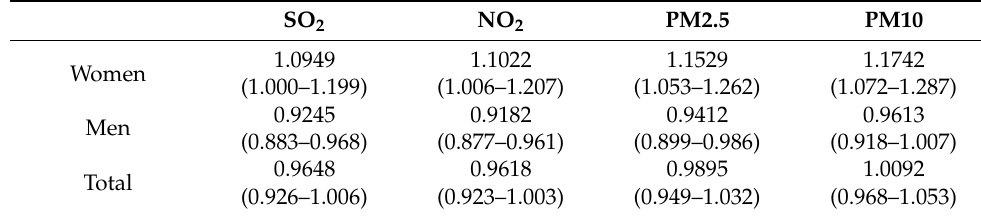
Table 2. Risk ratio for populations above the median (75+).